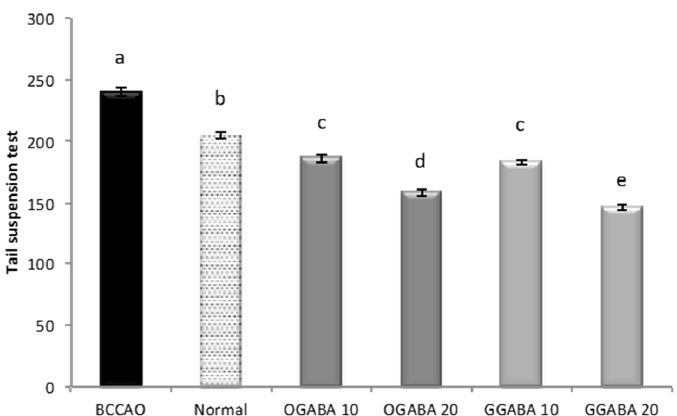
Figure 7. Effects of oral administration of OGABA and GGABA extracts on immobility time in tail suspension model. Data are mean(s) ± SD ( n = 7); different letters indicate statistically significant differences ( p < 0.05) between the two groups.